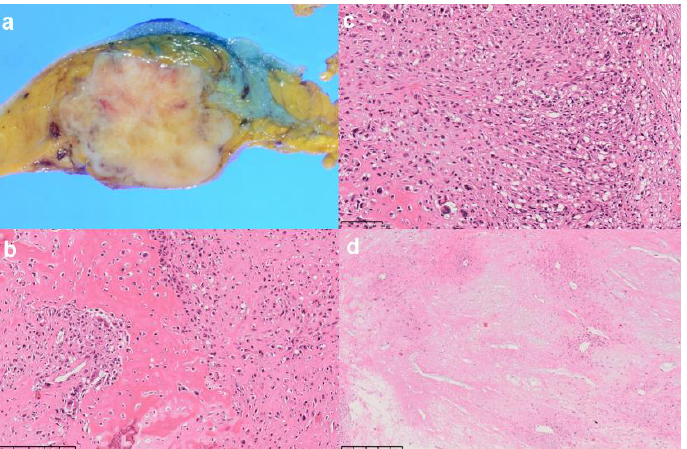
Figure 4. Gross examination of the specimen shows a firm mass with a variegated appearance, which measured 5 cm × 4 cm ( a ). Histologic examination reveals abundant periosteal formation, areas of calcification ( b ) and moderately pleomorphic oval to spindle-shaped stromal cells ( c ). Scattered multinucleated osteoclastic giant cells are also present ( b , c ). Necrosis is evident mainly in the central region of the tumor ( d ). The patient was finally diagnosed with primary breast osteo- sarcoma.